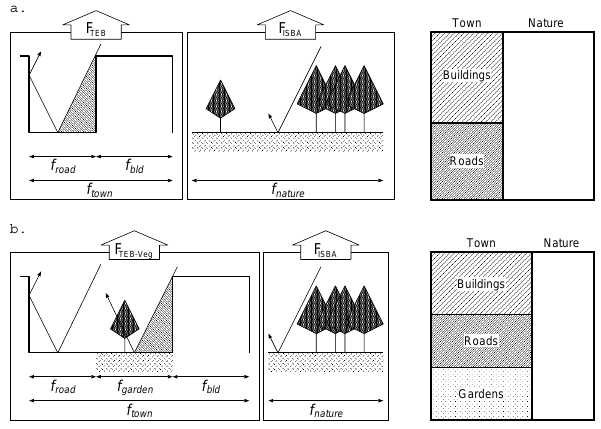
Fig. 1. Comparison of tiling approaches applied in TEB-ISBA (top) and TEB-Veg (bottom) to compute surface fluxes for a SURFEX’s grid point containing pervious and impervious